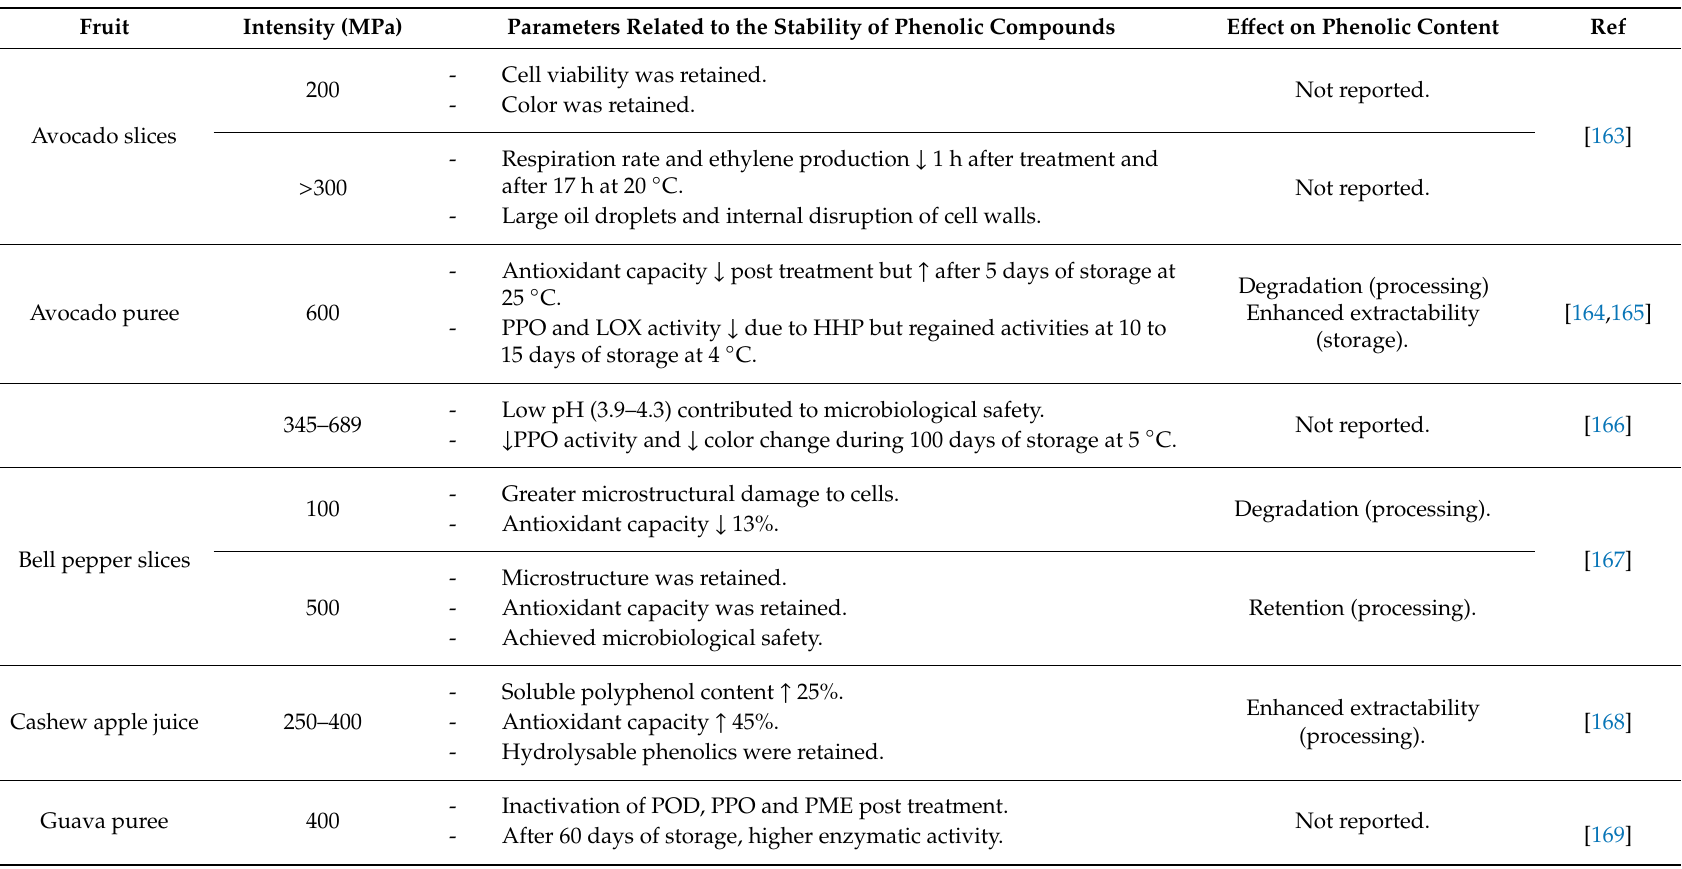
Table 5. E ff ects of High Hydrostatic Pressure (HHP) on phenolic compounds and parameters related to their stability in Mesoamerican fruits.